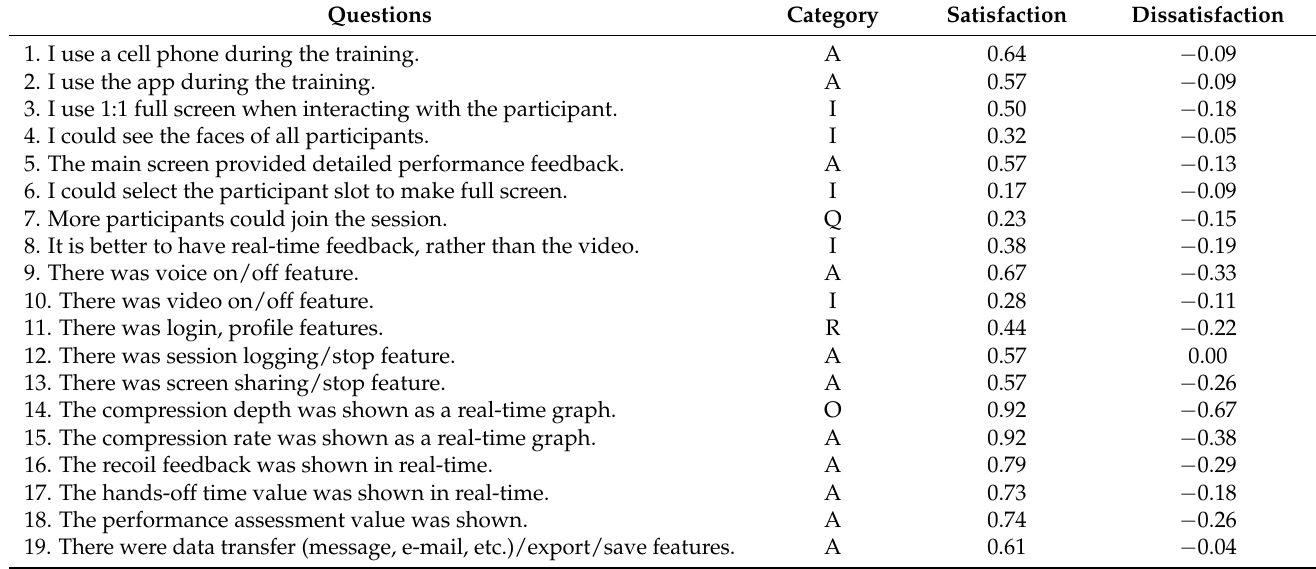
Table 1. Questions for Students ( n = 24).